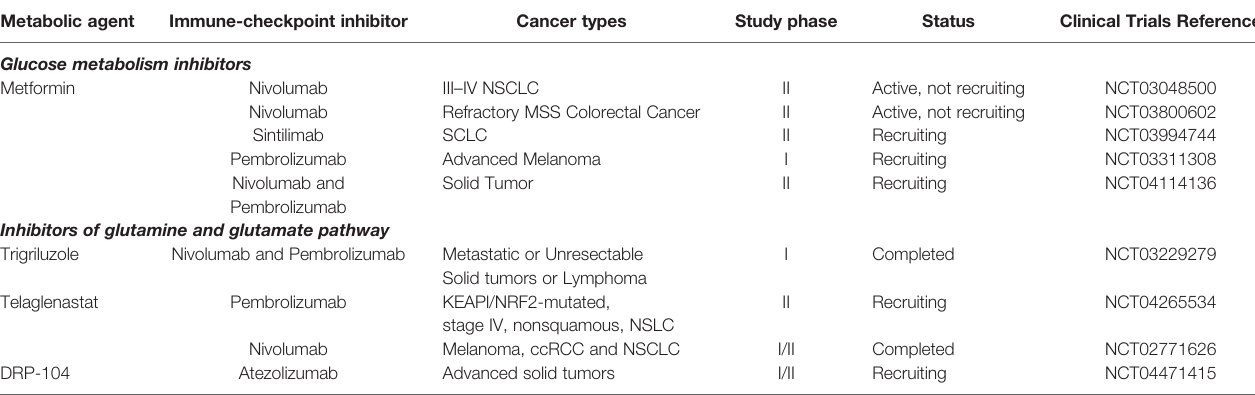
TABLE 1 | Currently ongoing trials of glucose and glutamine metabolic interventions combined with immune checkpoint inhibitors. Metabolic